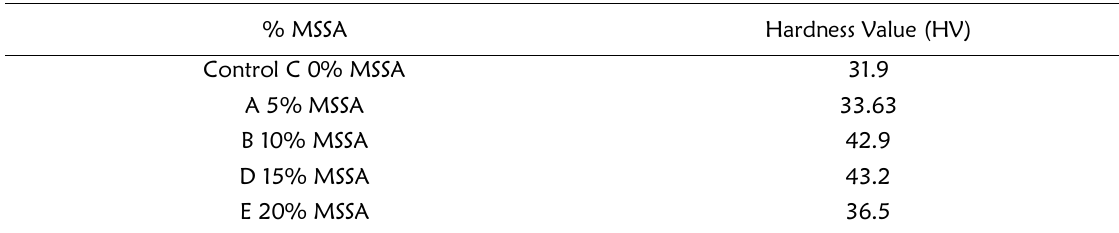
Table 7: Variation of hardness property of the